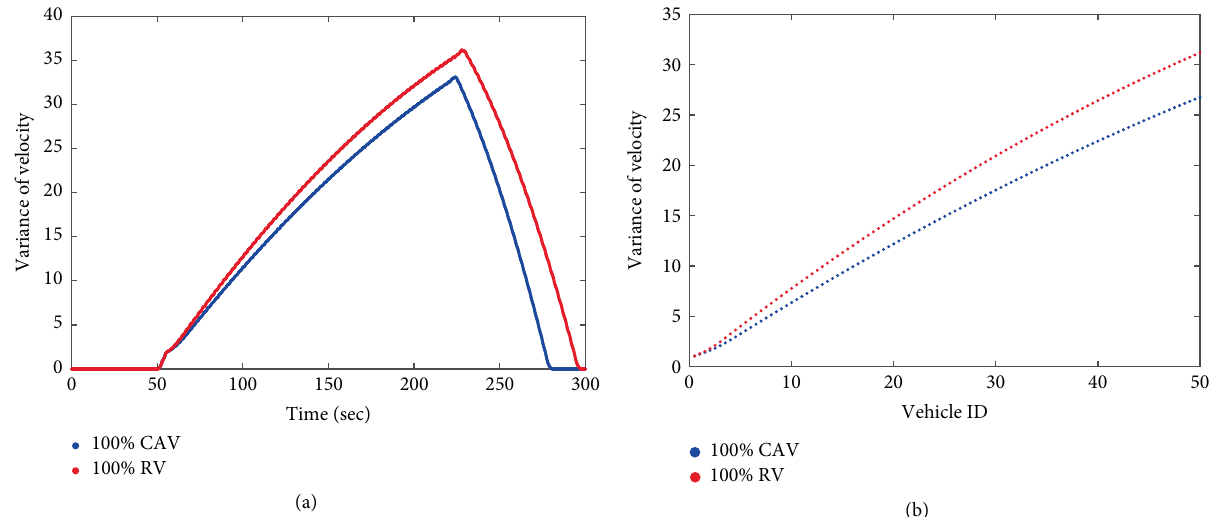
Figure 10: Variance of velocity of vehicles. (a) Time-varying variance of velocity of all vehicles. (b) Variance of velocity of every vehicle.